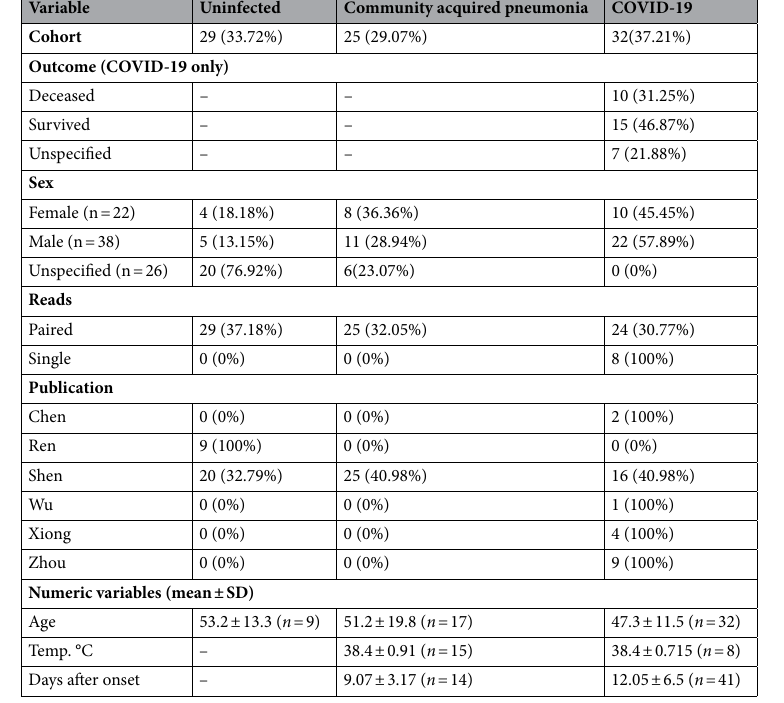
Table 1. Overview of meta-analysis dataset clinical characteristics ( n =